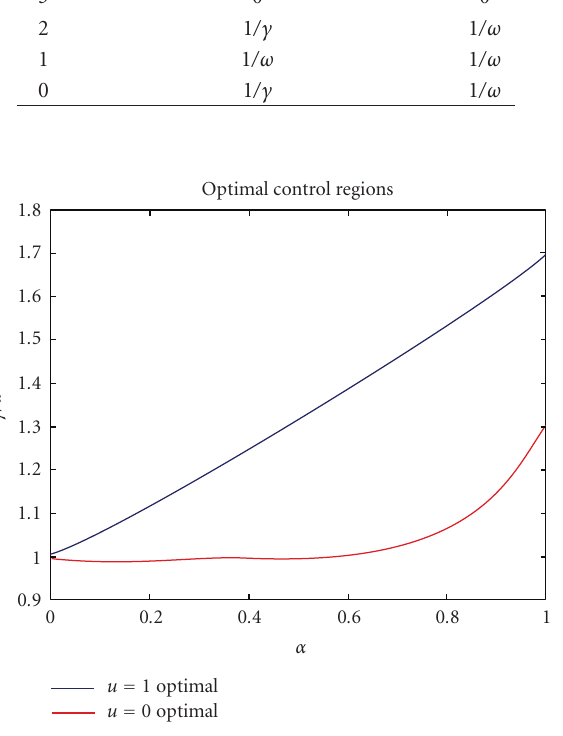
Figure 3: Optimal policy on the ( α , γ/ω )